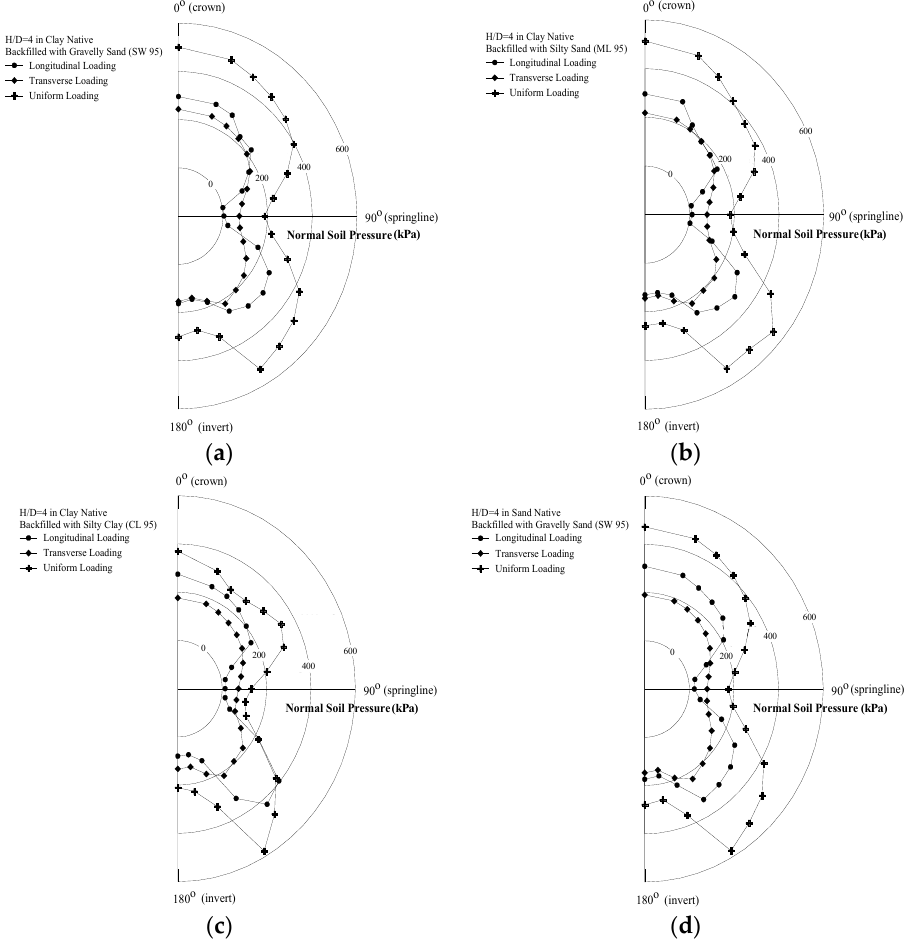
Figure 4. Variations in the normal soil pressure distributions under longitudinal, transverse, and uniform loading: ( a ) SW95 in clay native soil, ( b ) ML95 in clay native soil, ( c ) CL95 in clay native soil, and ( d ) SW95 in sand native soil.